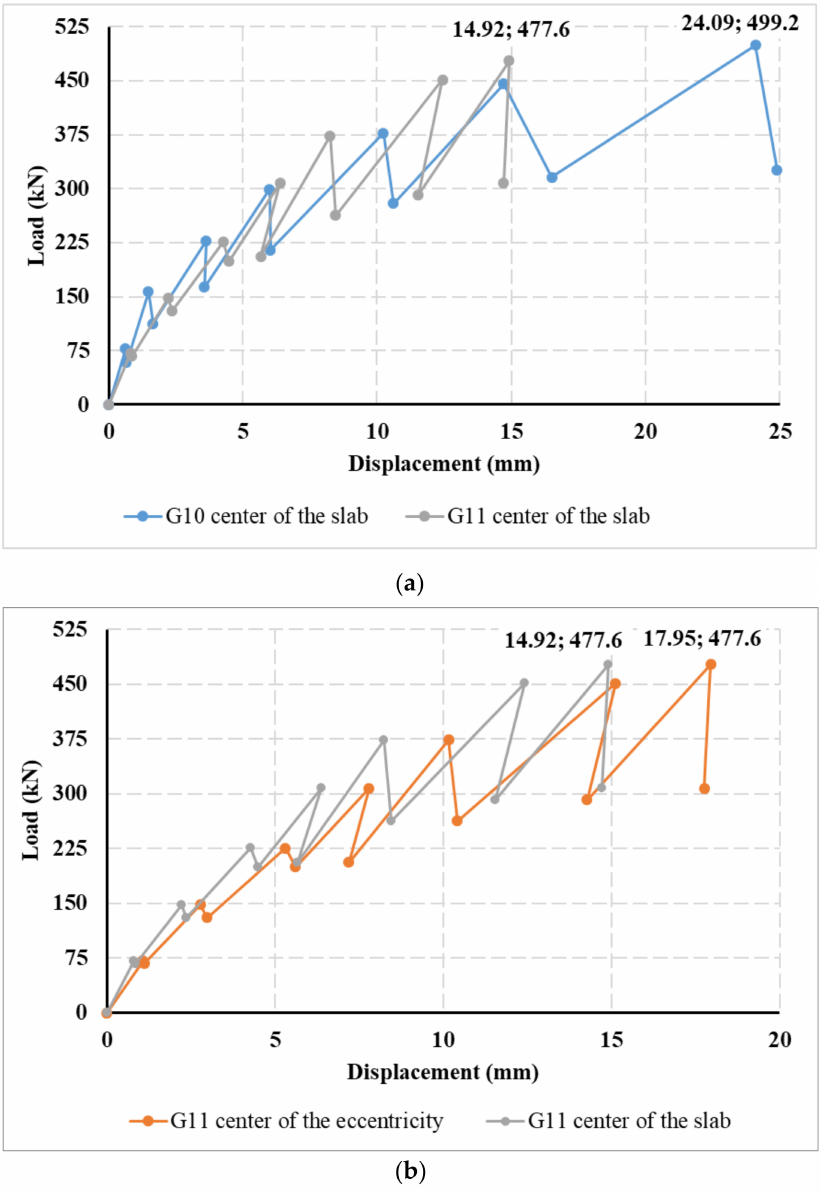
Figure 23. Load–displacement diagrams evaluated on the basis of the approximation of the 3D deformation surface: ( a ) in the center of centrically loaded slab G10 and eccentrically loaded slab G11; ( b ) in the center of the slab and the center of eccentricity of eccentrically loaded slab